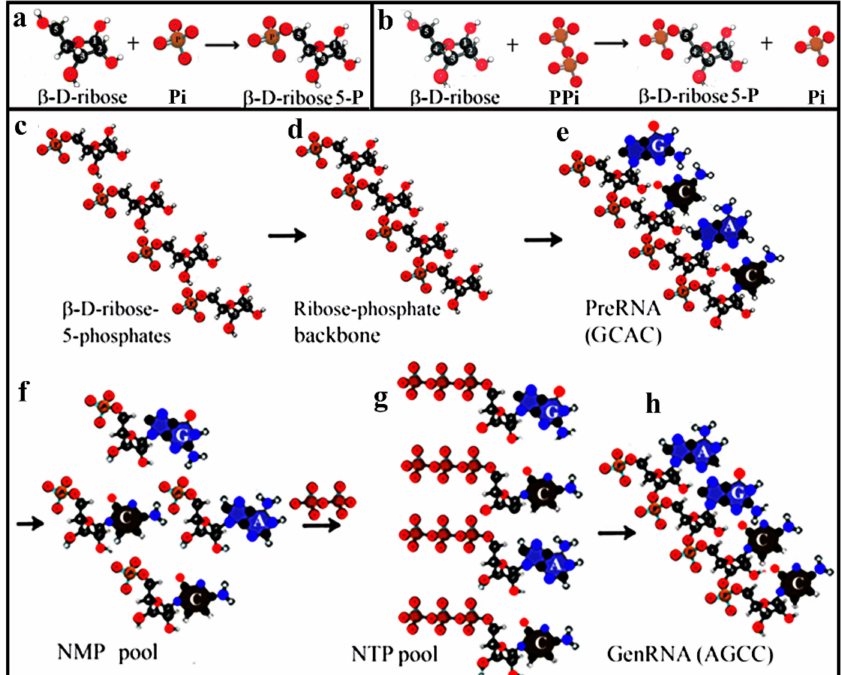
Figure 3. Selection of β - D -ribose as the best fitting pentose in the nucleotide structure. The two gen- erally known phosphorylations of β - D -ribose are ( a ) phosphorylation with inorganic phosphate [39], ( b ) regioselective phosphate transfer from the activated pyrophosphate complex [40]. Before abiotic RNA generation is dealt with, it should be pointed out repeatedly that prebiotic reaction condi- tions, such as the formose reaction, can at best produce racemic ribosephosphate and other racemic compounds but no enantiomerically pure D -ribofuranose derivatives. Prebiotic RNA formation: ( c ) accumulation of β - D -ribose, ( d ) Polymerization of the sugar-phosphate backbone from β - D -ribose 5-phosphate units, ( e ) N-glycosidic bond formation between nucleobases and hydroxyl groups of the sugar-phosphate skeleton to bring about a random base, non-genetic preRNA. ( f ) Hydrolytic cleavage of nucleoside monophosphates and catalytic oligomers (not shown) from prebiotic RNA. ( g ) Phosphorylation with pyrophosphate (PPi) to NTPs. ( h ) NTPs serving as a pool for the synthesis of genetic RNA. Abbreviations: G, guanine; A, adenine; C, cytosine. Modified with permission